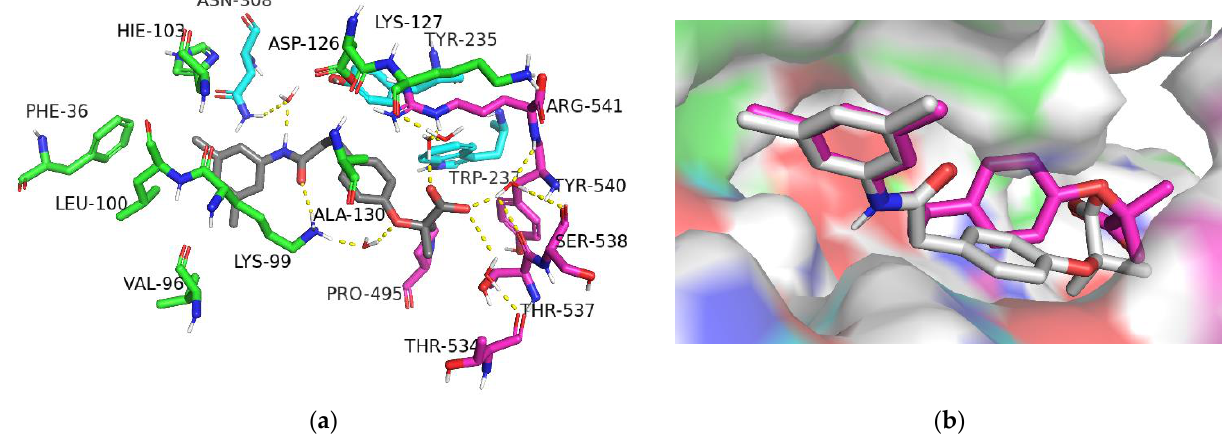
Figure 5 . Proposed binding mode of target compound 19c . Protein, water and effector atoms are shown as sticks, and hydrogen bonds are shown as dash lines. For clarity, not all residues lining the allosteric binding site are shown. ( a ) Proposed binding mode of compound 19c (gray) with deoxygenated hemoglobin. ( b ) Binding overlap of efaproxiral (light gray) and compound 19c (pink) in the binding site.